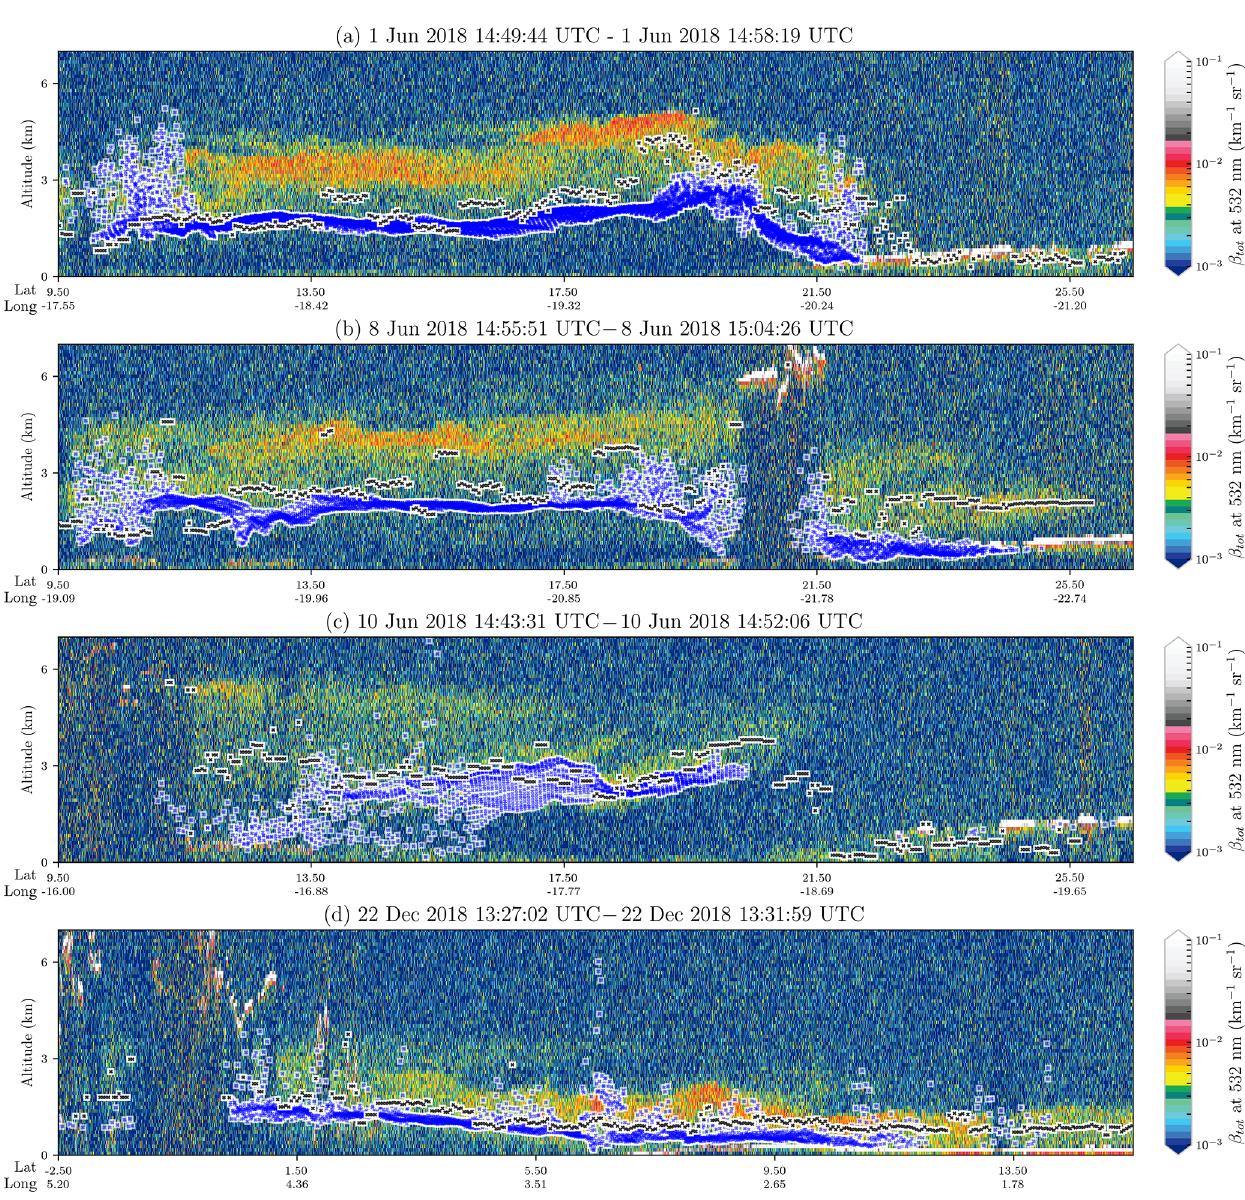
Figure 6. CALIOP level-1 backscatter curtain plots for measurements in the 532nm channel for the four selected cases in Fig. 5. The blue markers (crosses over a white box) represent co-located TROPOMI ALH retrievals within 100km of each CALIOP profile present in this plot. The black markers (crosses over a white box) represent the CALIOP weighted aerosol heights as computed using Eq. (2). TROPOMI data that are either in the sun-glint region or cloud contaminated are removed (cloud detection is done using the cloud_warning flag from Table